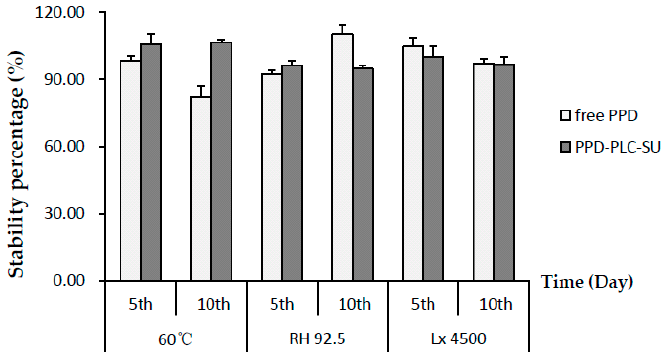
Figure 11. Stability investigation results of PPD and PPD-PLC-SU ( n = 3, mean ± SD).